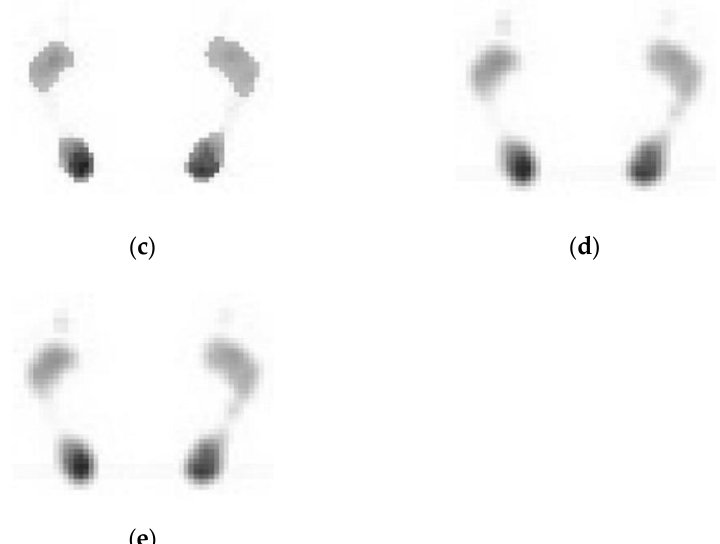
Figure 4. ( a ) shows the definition of the 8-neighborhood correlation pixel and ( b ) is the original plantar pressure image generated by the sensor data and the result after using the 8-neighborhood correlation pixel method. ( c ) is the result of median filtering, ( d ) is the result of Gaussian filtering and ( e ) is the result of mean filtering.